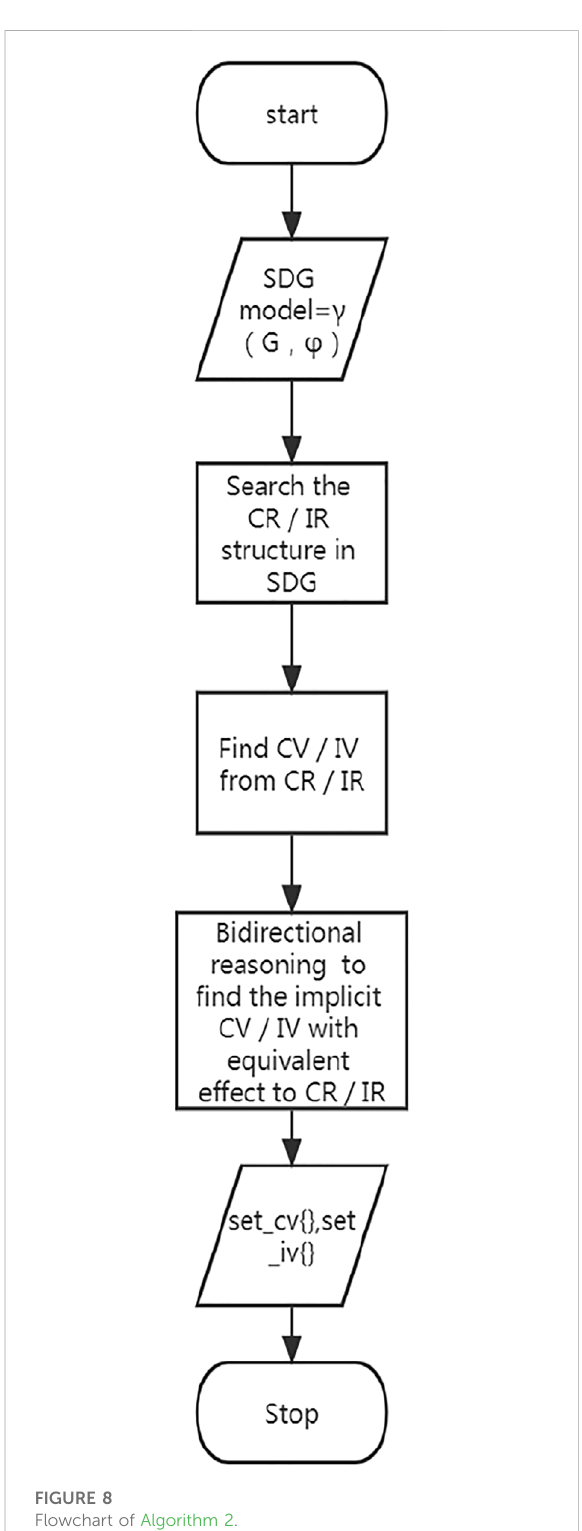
FIGURE 8 Flowchart of Algorithm